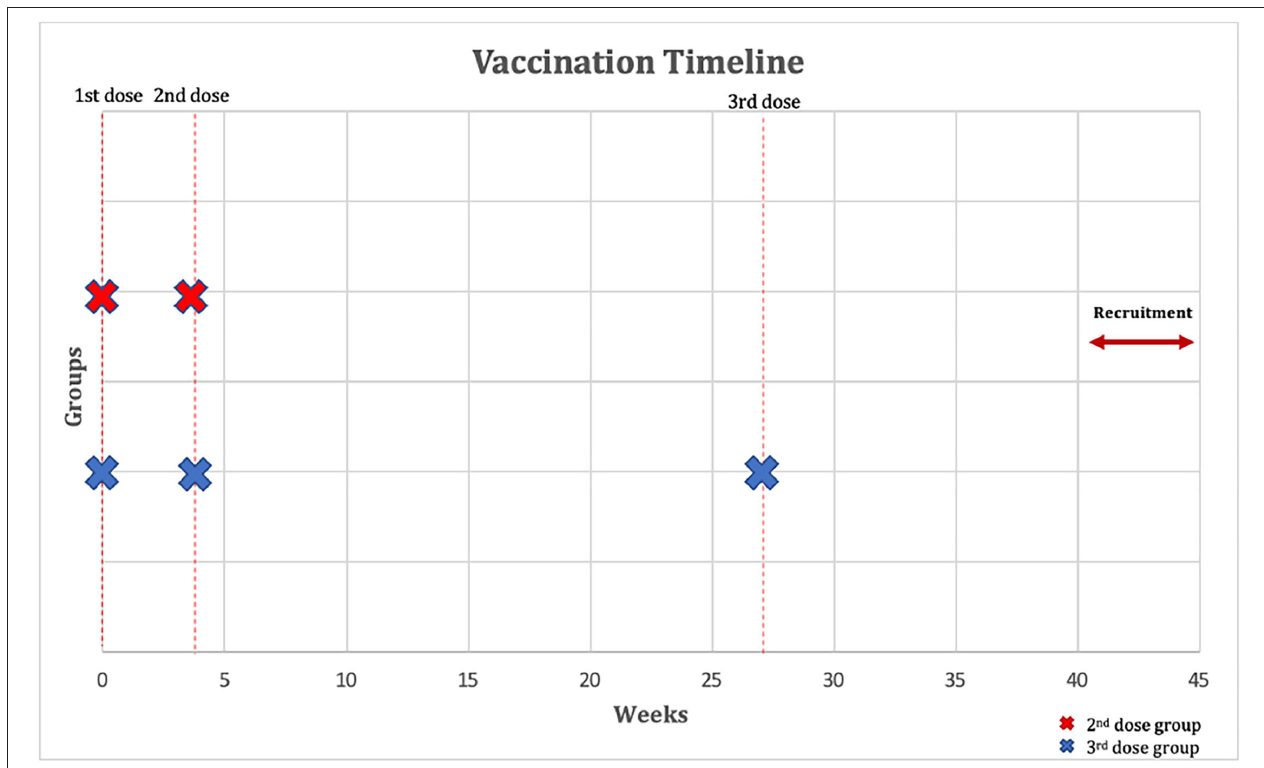
FIGURE 1 | Outline of vaccination timeline and time when a serological response was assessed. The figure shows that participants have received two-dose of COVID-19 vaccination with BNT162b2 vaccine 3 weeks apart and that the third (booster) dose group have received a third dose with BNT162b2 vaccine 24 weeks after the second dose. Immunoglobulin G (IgG) and neutralizing antibodies were measured 40–45 weeks after their first dose of BNT162b2.